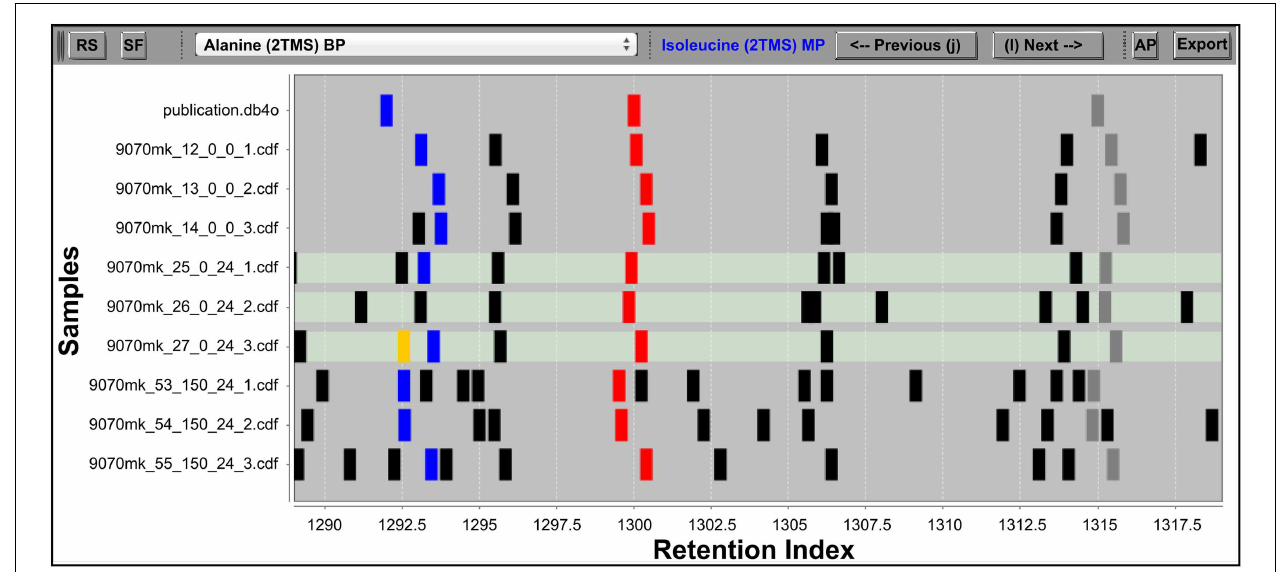
metabolite database followed by rows of samples, and peaks abstracted into vertical bars are plotted along the x -axis according to their RI. Differently colored peaks indicate different stages of processing: unknown peaks are black, putatively identified peaks are red, the library entry currently selected and its corresponding putative identifications in the samples are colored blue, while the horizontal traversal within a sample as controlled by the MSView is indicated by orange.The three highlighted rows of samples are displayed in the